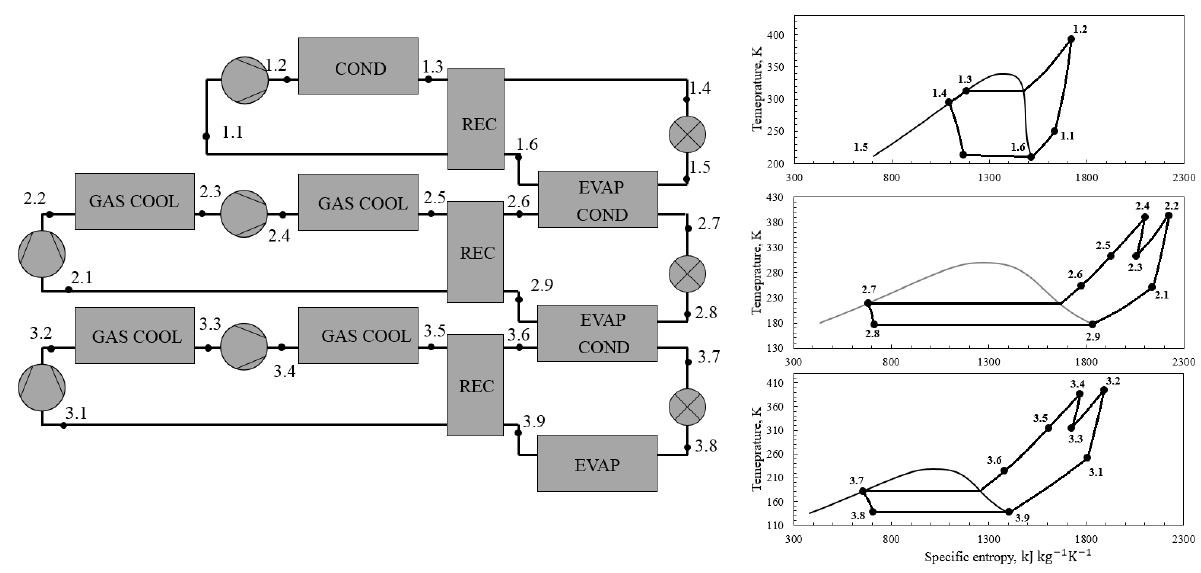
Figure 4. The scheme of a three-stage cascaded refrigeration system with two-stage compression.